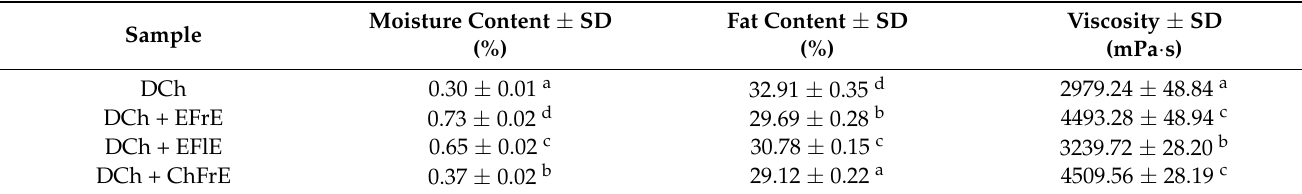
Table 5. Physicochemical parameters of the investigated